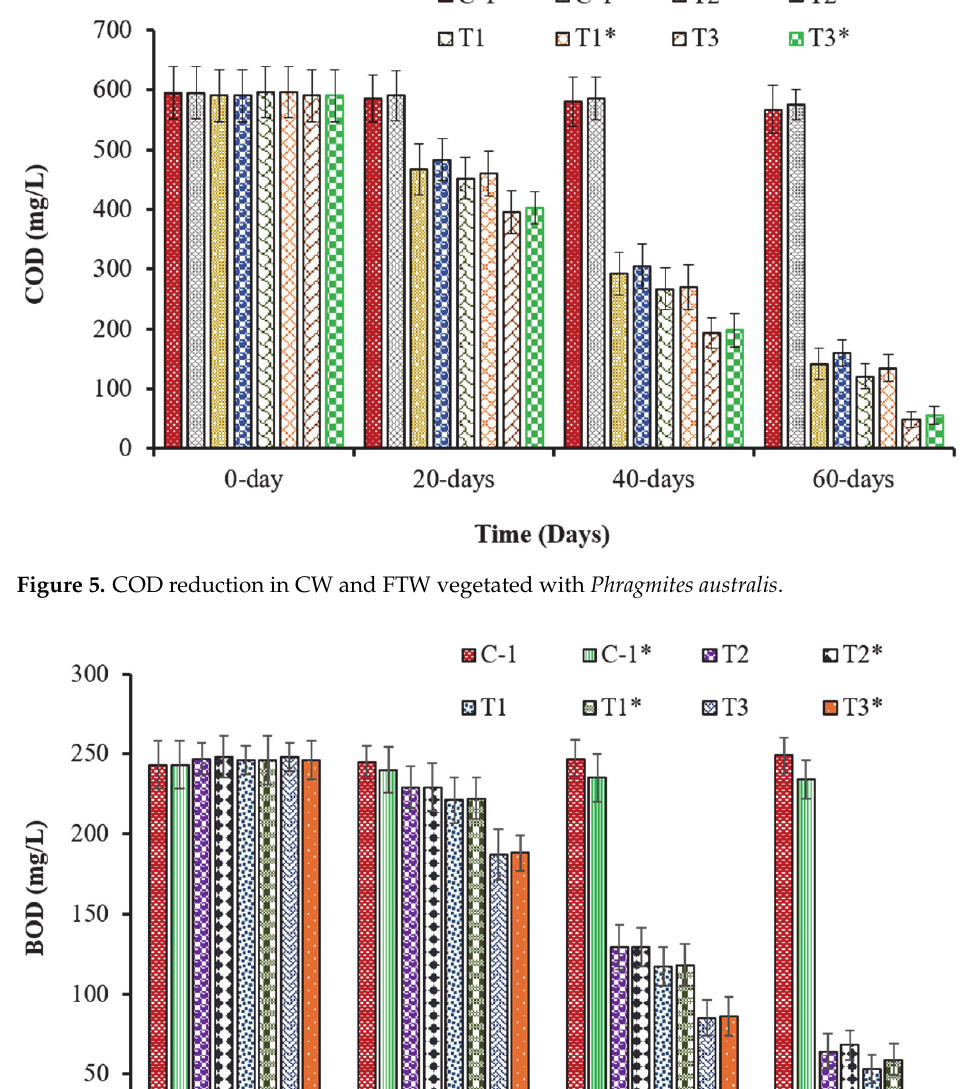
Figure 7. Phenanthrene reduction in CWs and FTWs vegetated with Phragmites australis.